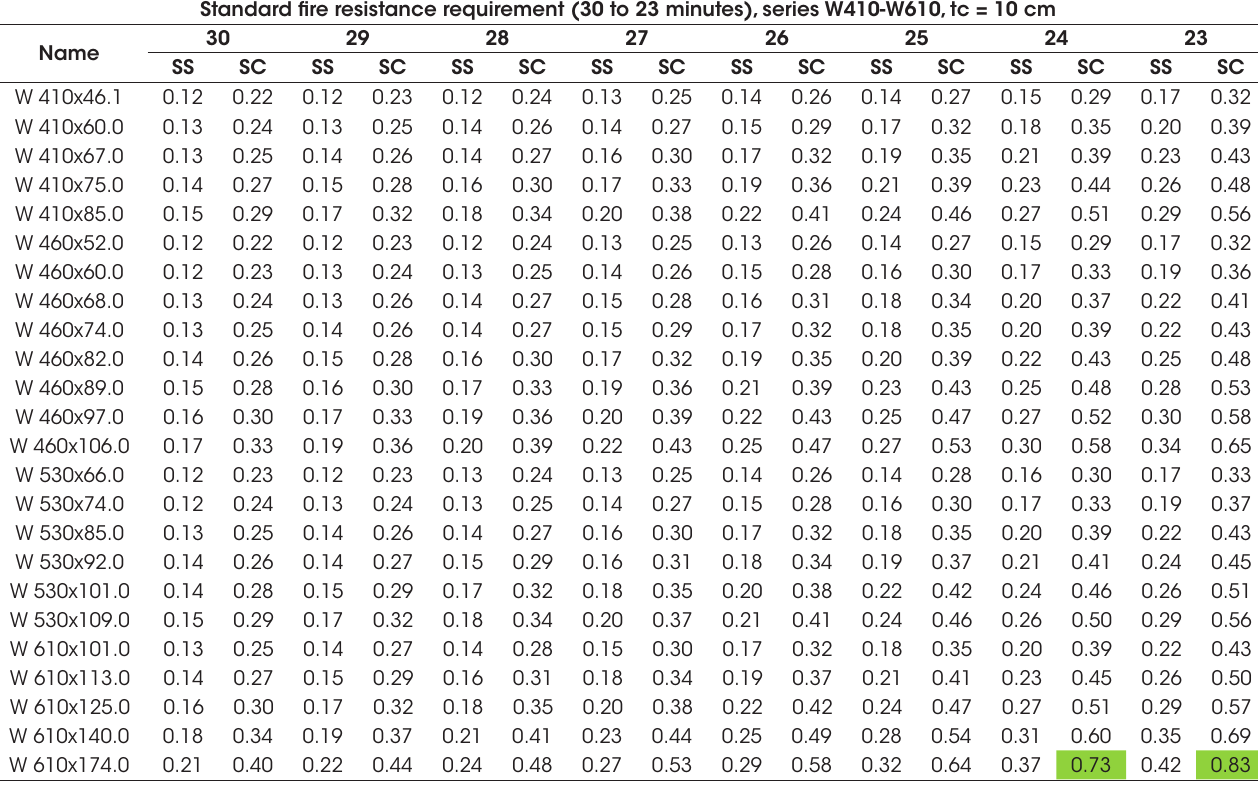
Load factors as function of the standard fire resistance requirement for composite beams with 10 cm slab and Gerdau profile series W410-W610